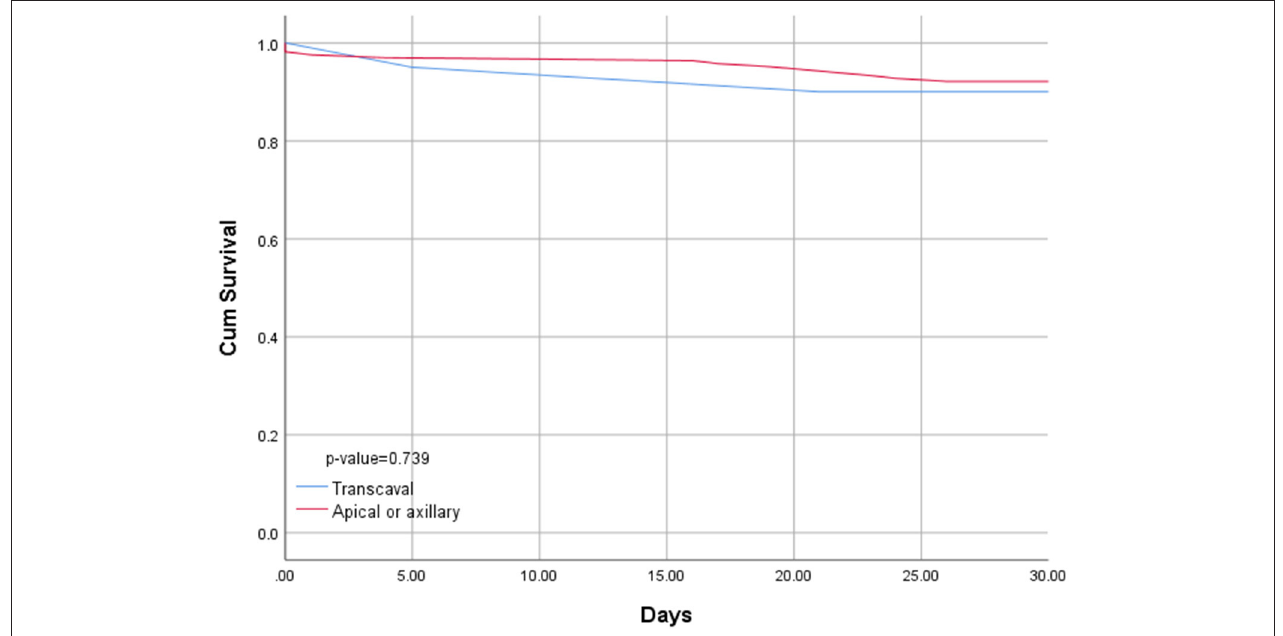
FIGURE 4 | Kaplan–Meyer survival curve of patients undergoing transcaval vs. alternative access transcatheter aortic valve replacement.